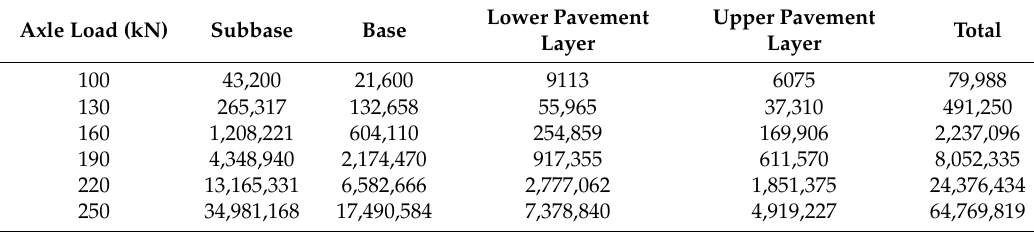
Table 5. Standard axle load times of carrier